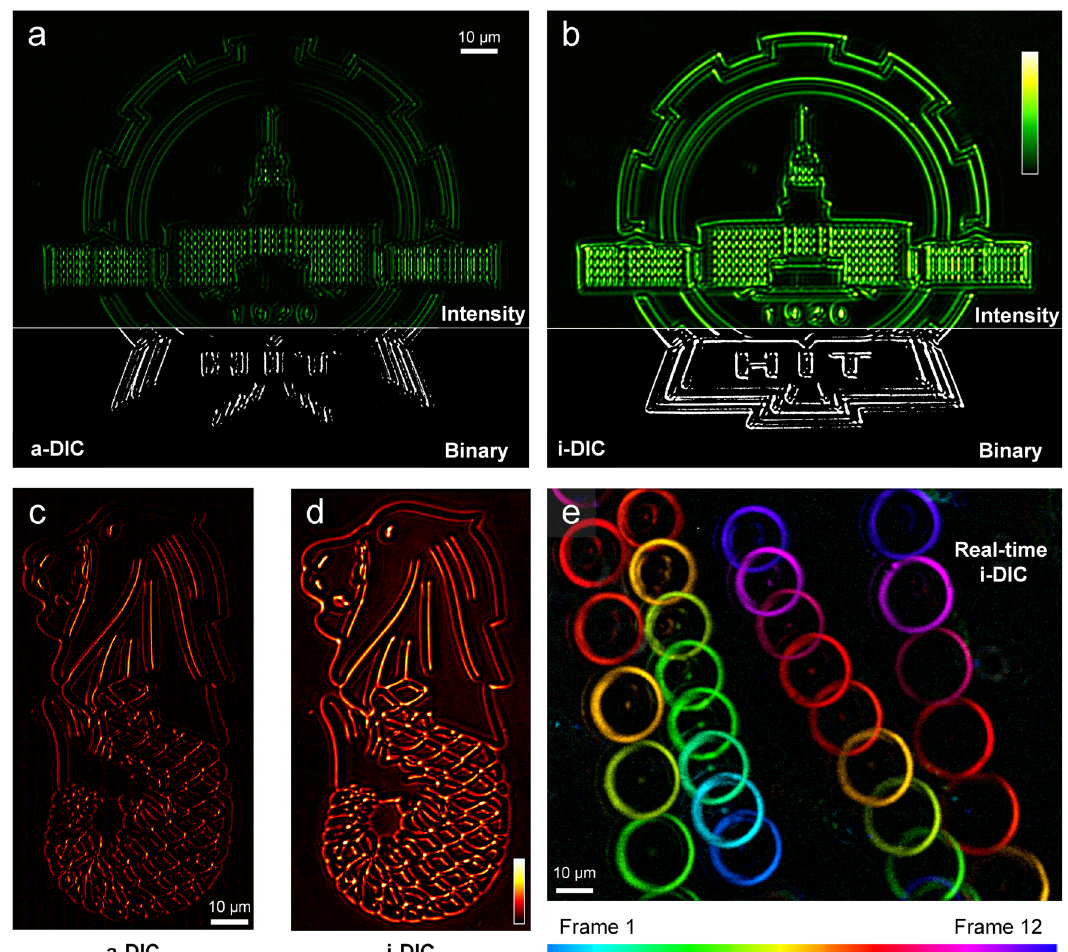
Fig. 3 | Imaging results with a-DIC and i-DIC microscopy. The high-resolution icon imaging results in a-DIC microscopy ( a , c ), i-DIC microscopy ( b , d ) with NA=0.7, λ =620nm. e The motion tracking of SiO 2